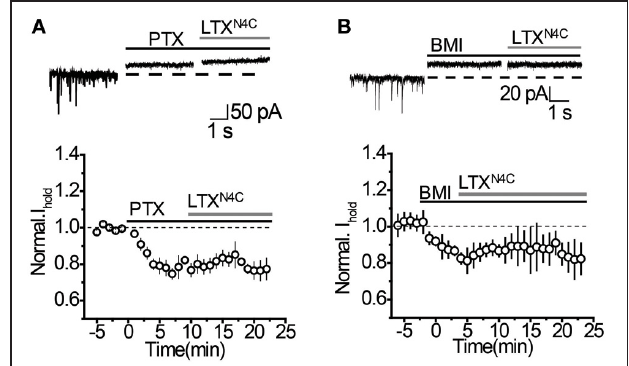
FIGURE 7 | LTX N4C -mediated increase in I hold is blocked by GABA A receptor antagonists. (A) Top : Representative traces showing that picrotoxin (PTX, black solid line ) completely blocks the increase in I hold produced by LTX N4C ( gray line ). Dashed line —baseline I hold . Bottom : Effect of PTX and LTX N4C on I hold normalized to the baseline (dashed line , n = 4). Solid black line —application of PTX, solid gray line —application of LTX N4C . (B) Top : Representative traces showing no increase in I hold by LTX N4C ( gray line ) in the presence of bicuculline (BMI, black solid line ). Dashed line —baseline I hold . Bottom : Effect of BMI and LTX N4C on I hold normalized to the baseline (dashed line , n = 4). Solid black line —application of BMI, solid gray line